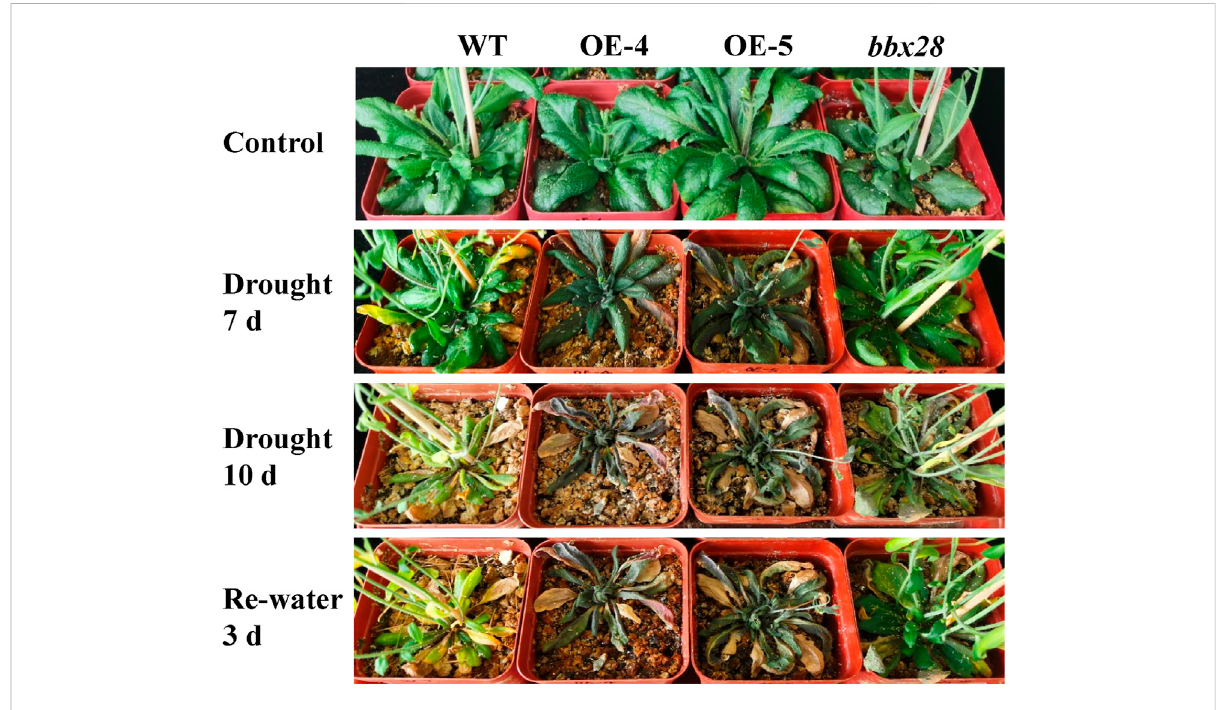
FIGURE 4 The phenotype of overexpressing IbBBX28 transgenic Arabidopsis and bbx28 T-DNA insertion Arabidopsis under drought stress. The experimentswereperformedthreetimeswithsimilarresults. Thereweremorethan10plantsineachreplication.Thephotographs depicttheresults of one of the three